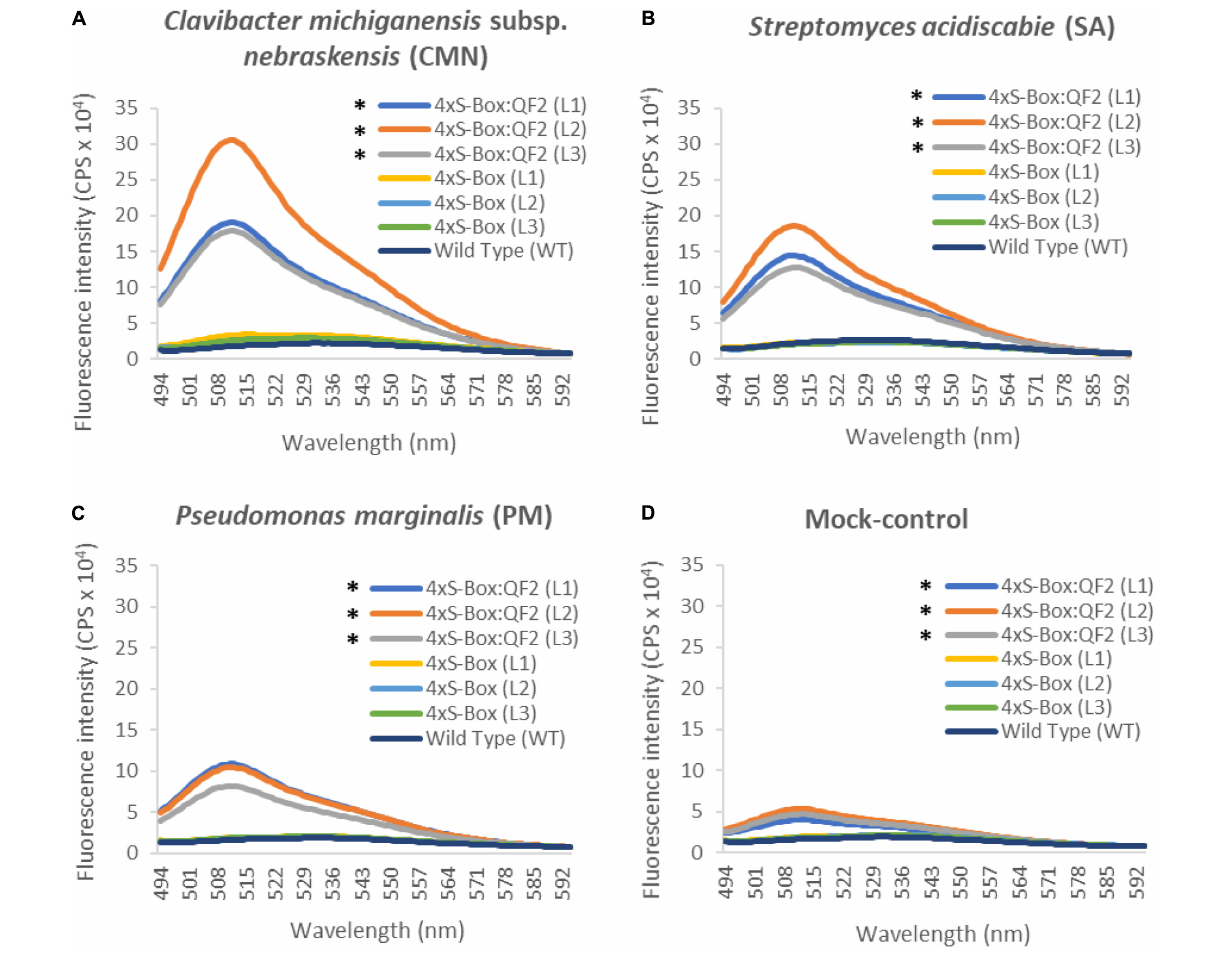
FIGURE 3 | Spectro-fluorescence signal amplification in pathogen phytosensors. Full spectral analysis from transgenic phytosensor 4xS-Box:QF2 (with Q-system) and 4xS-Box (without Q-system), and wild-type pants inoculated with bacterial pathogens (A) Clavibacter michiganensis subsp. nebraskensis (CMN), (B) Streptomyces acidiscabie (SA), (C) Pseudomonas marginalis (PM), and (D) 10 mM MgCl 2 (mock-control). Plants were infiltrated with a bacterial inoculum of OD 600 = 0.3, corresponding to colony forming units (cfu) of 3 × 10 8 cfu/ml CMN, 3 × 10 8 cfu/ml SA, and 1 × 10 8 cfu/ml PM. Spectral data represent mEmerald emission of treated leaves at 72 h post inoculation. Spectral data measured at 475 nm excitation and 494 − 594 nm emission wavelengths. Statistical significance determined for all data points across spectrum using repeated measures ANOVA, Tukey HSD post hoc analysis. Asterisks (*) indicate significant difference ( p < 0.05), compared with WT (wild type) and 4xS-Box. In total three independent experiments with four biological replicate plants ( n = 4) per experiment was performed. In total three independent lines (L1, L2, and L3) were tested for each construct. In total three technical replicate spectral readings were collected on a single leaf for each biological replicate per experiment to account for positional error. Data represent mean ± standard error of 36 spectral